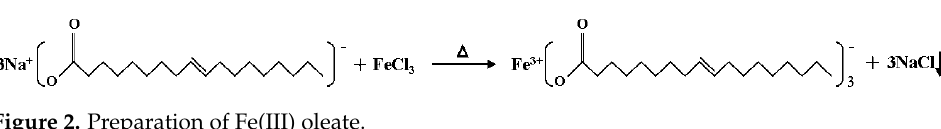
Table 1. The physical parameters of Heavy oil.